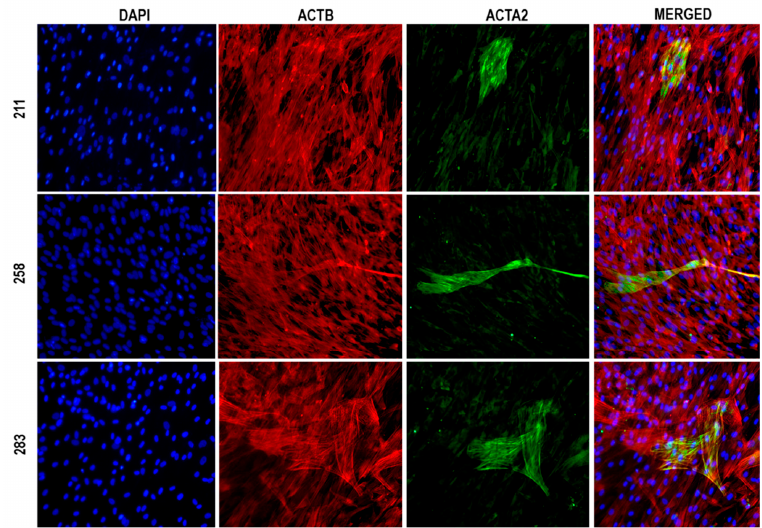
Figure 2. Pre-myofibroblastic nature of mesenchymal stem/stromal cells (MSCs). Immunofluorescence microscopy showing cellular morphology of MCSs from three donors (211, 258 and 283). The panels show DNA staining in the nucleus (DAPI, blue), as well as cytoskeleton staining of smooth muscle β -actin (ACTB; red) and smooth muscle α -actin (ACTA2; green). Modified ACTA2 stress fibers are apparent in a subset of cells that resemble the myofibroblast phenotype. Images were captured with a 10 × objective. J. Clin. Med. 2020 , 9 , x Depletion of ADIPOR1 and ADIPOR2 mRNAs using gene-specific siRNAs was validated by RT-qPCR (Figure 3). A significant decrease in ADIPOR1 and ADIPOR2 gene expression was observed in cells from all three donors (i.e., 211, 258, 283), but these values only reached statistical significance in a subset of the samples. This observation is likely due to variation in biological replicates.